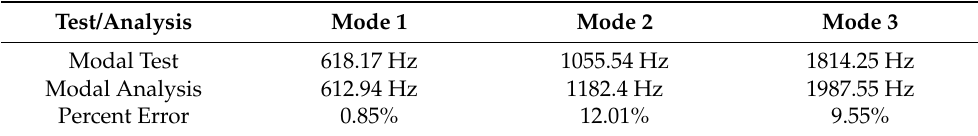
Table 6. Comparison of test and analysis results for the coil